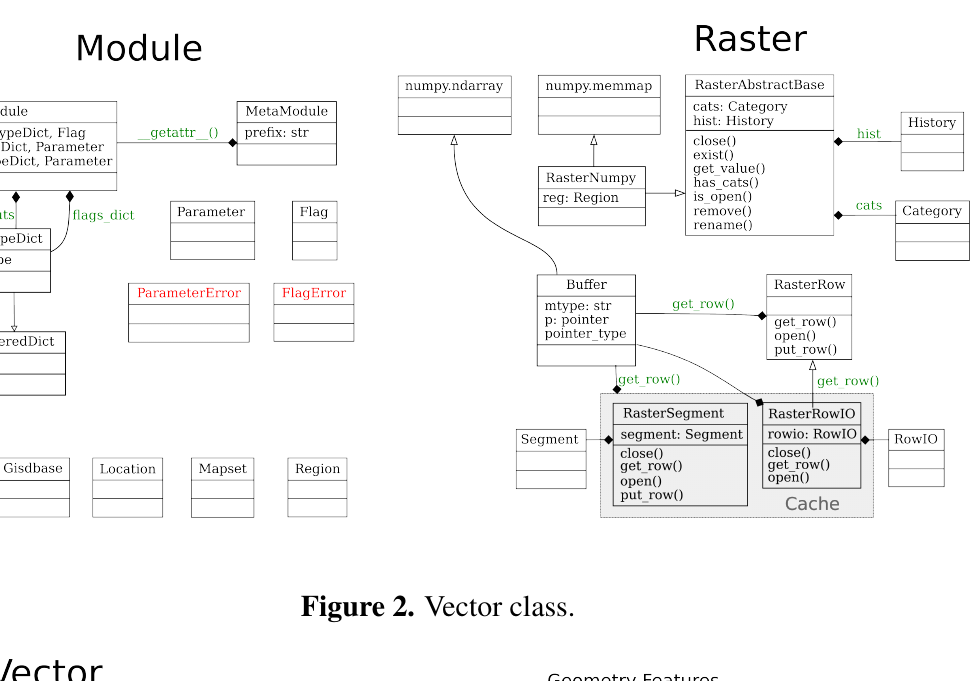
Figure 1. Module, Raster and GIS classes.